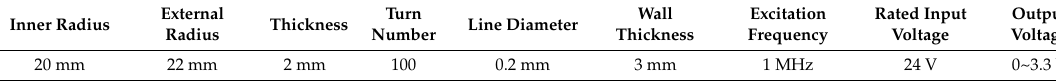
Table 3. Specific parameters of eddy current sensor.